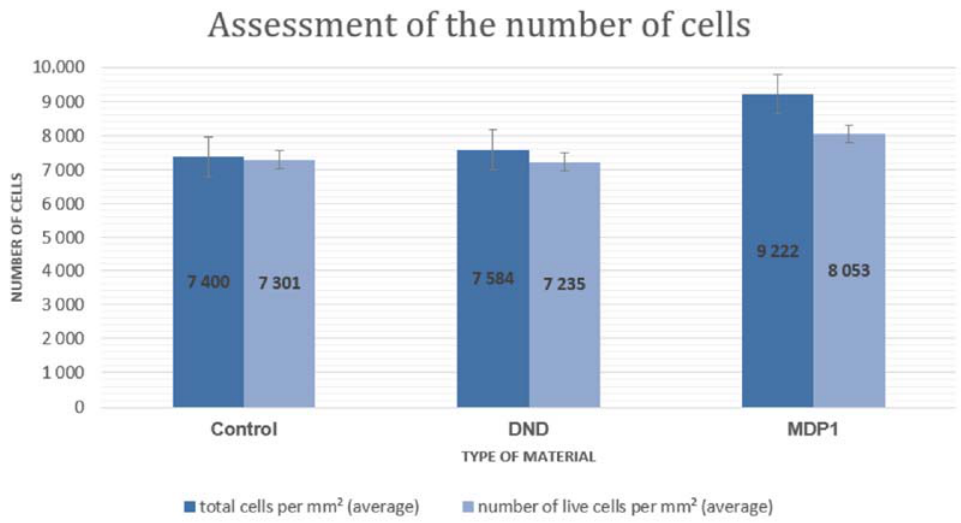
Figure 1. Assessment of the number of total cells in a given unit area and assessment of the number of live cells per unit area.